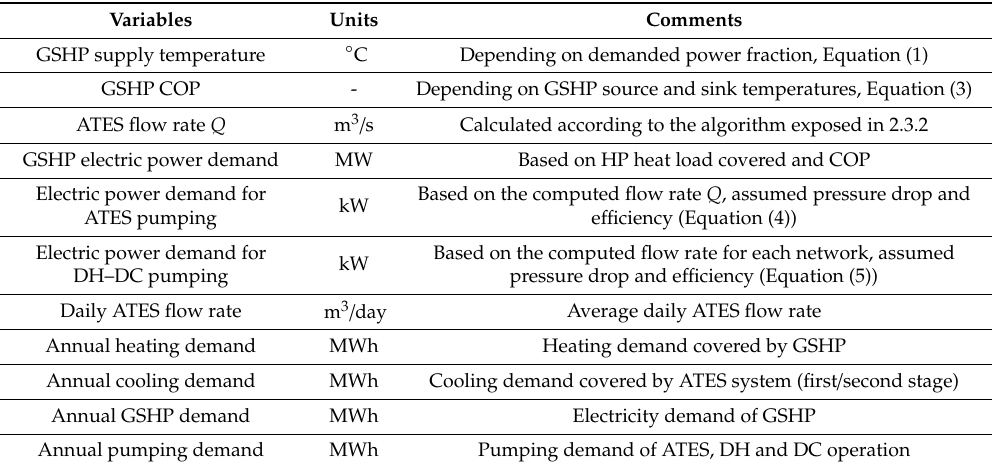
Table 2. Technical variables of Table 2 . Technical variables of ATES